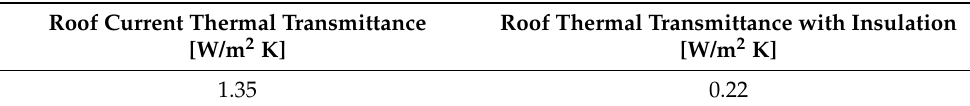
Table 7. Thermal transmittance of the insulated and non-insulated roof.